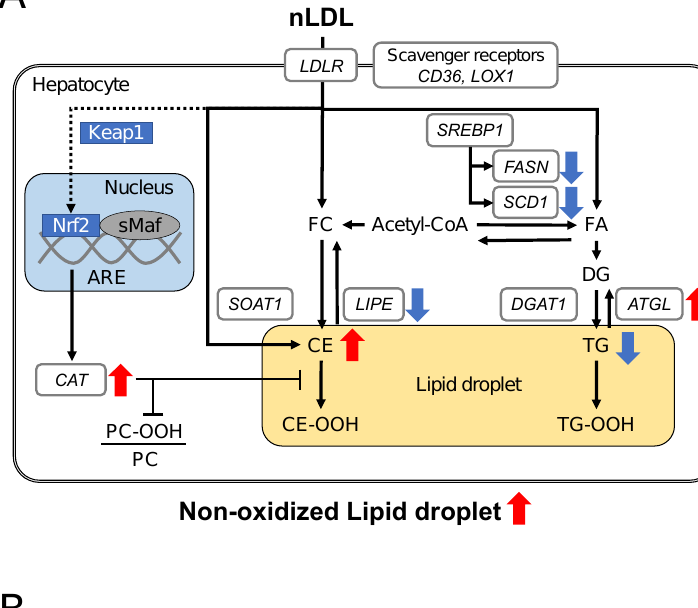
Figure 6. Expression of genes related to lipid metabolism in the LDL-supplemented C3A cells de- tected using real-time PCR. ( A ) Biosynthesis and degradation of CE: SOAT1 and LIPE ; ( B ) Biosyn- thesis and degradation of TG: DGAT1 and ATGL ; ( C ) Biosynthesis marker of fatty acids: SREBP1 , FASN , and SCD1 ; ( D ) Antioxidants: CAT . Results are shown as the relative expression levels com- pared to the control (PBS), which was set to 1.0. n = 6 – 8. One- way ANOVA with Tukey’s multiple comparisons test, * p < 0.05, ** p < 0.01, *** p < 0.001, **** p < 0.0001, n.s. not significant. From the above results, the lipid metabolic changes in nLDL- (Figure 7A) and oxLDL- supplemented C3A cells (Figure 7B) are summarized.